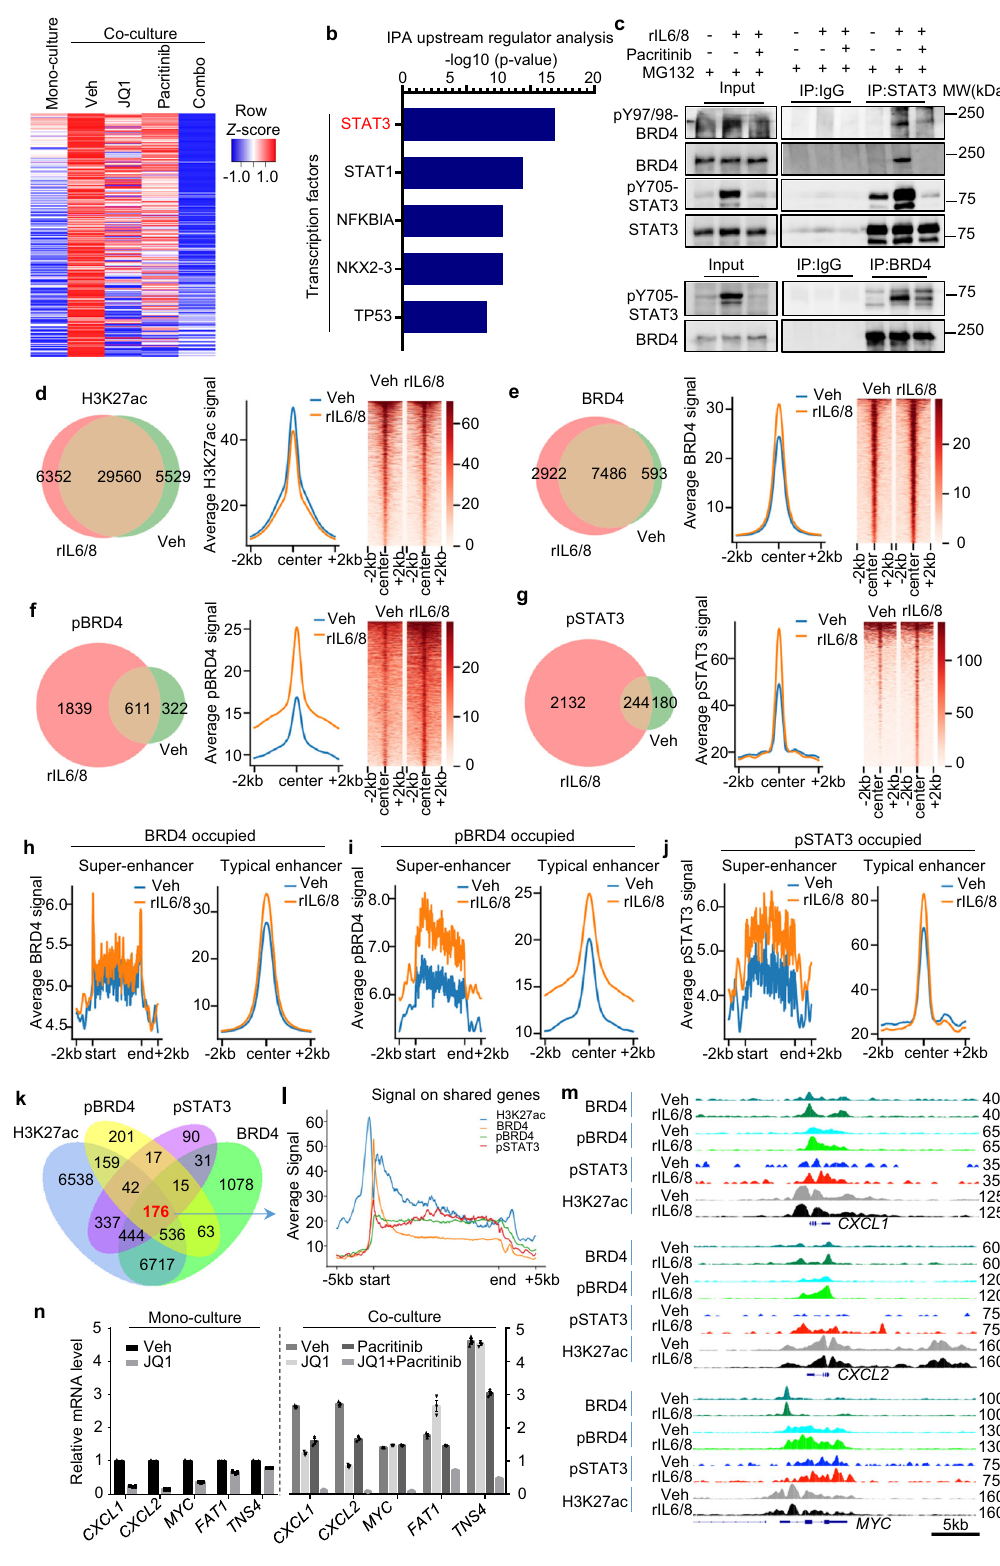
agarose-bound Flag-tag-BRD4 in kinase assay buffer (10 mM HEPES, 50mM NaCl, 5mM MgCl 2 , 5mM MnCl 2 , 0.1 mM Na 3 VO 4 , and 1 mM